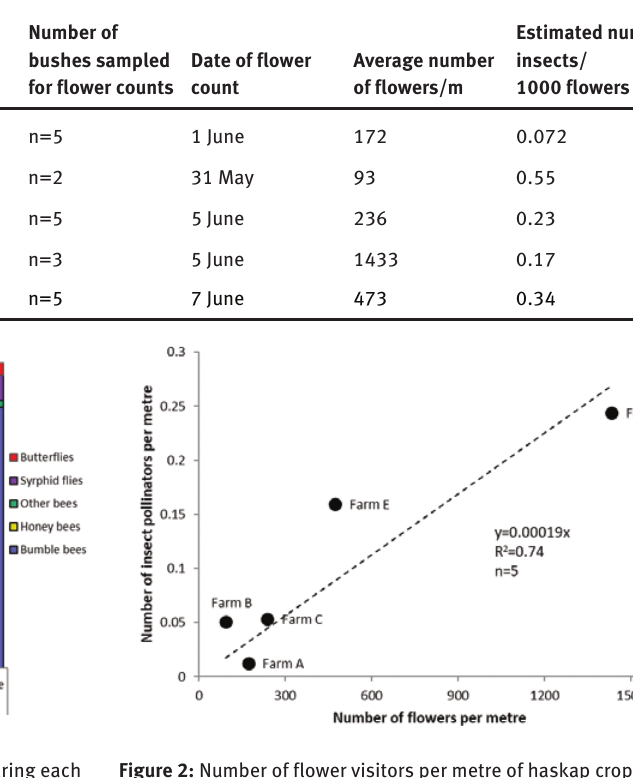
Figure 2: Number of flower visitors per metre of haskap crop vs. number of flowers per metre. Farms A, C and D had honey bees whereas Farms B and E did not.